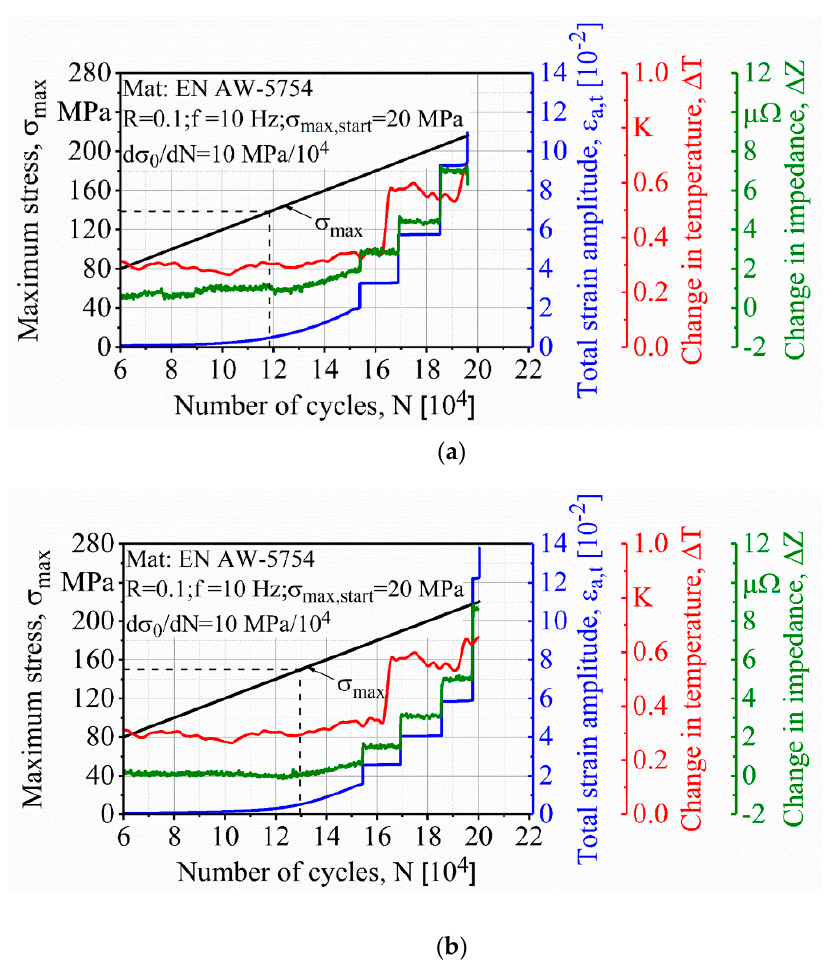
Figure 7. Load increase test results for specimens made by ( a ) conventional and ( b ) stationary shoulder FSW.